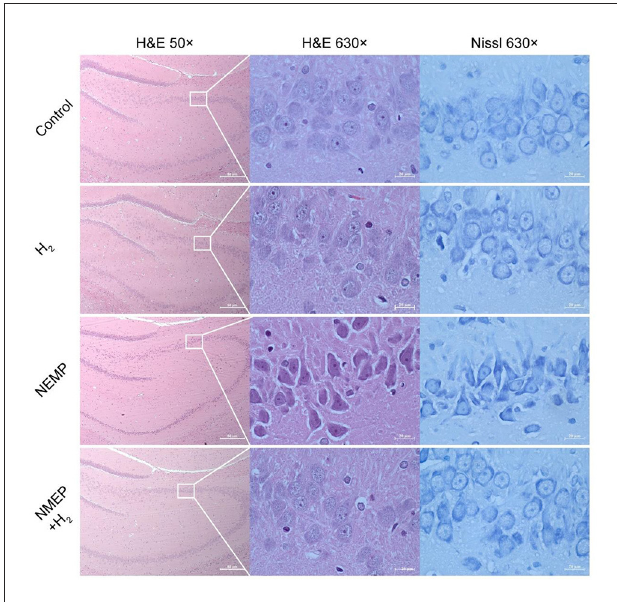
FIGURE4 Representative micrographs of the hippocampus each group (H&E and Nissl staining). N = 4.